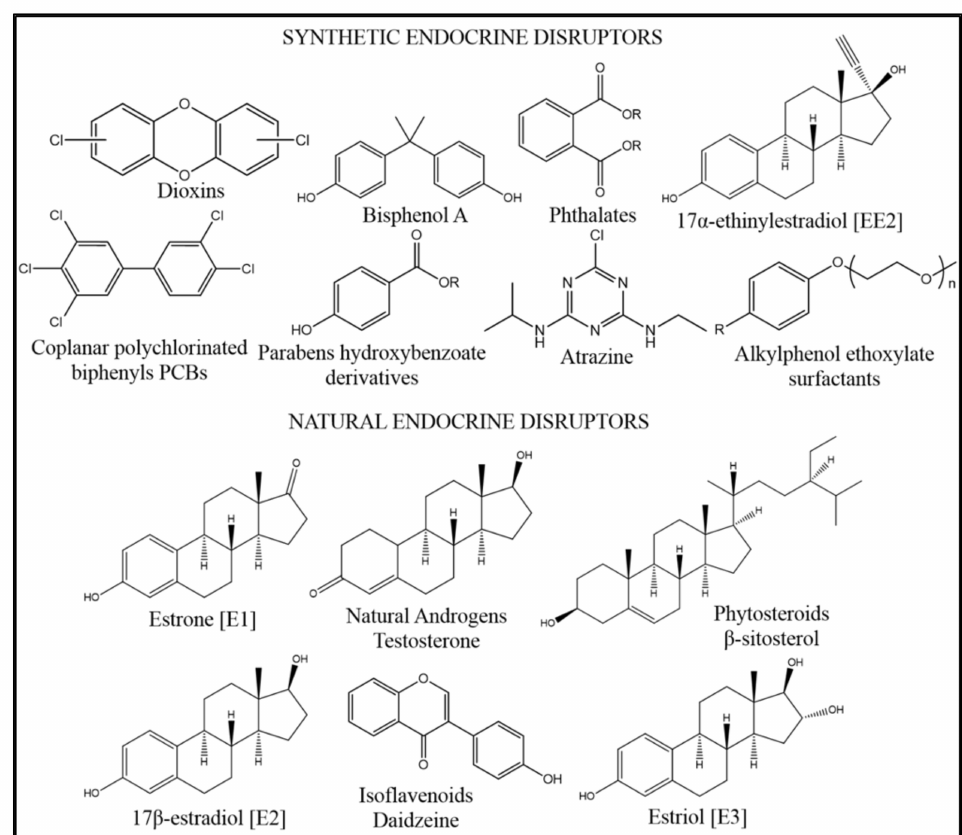
Figure 1. Structure of common synthetic and natural endocrine